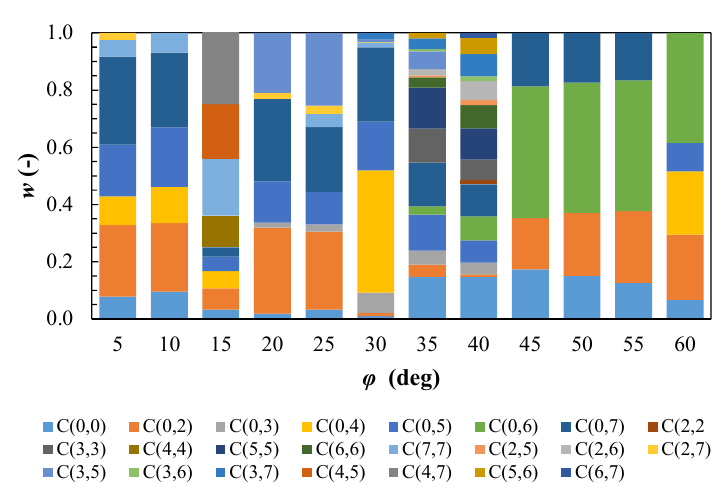
Figure 7. Absolute value of regression coefficients normalised in [ 0,1 ]